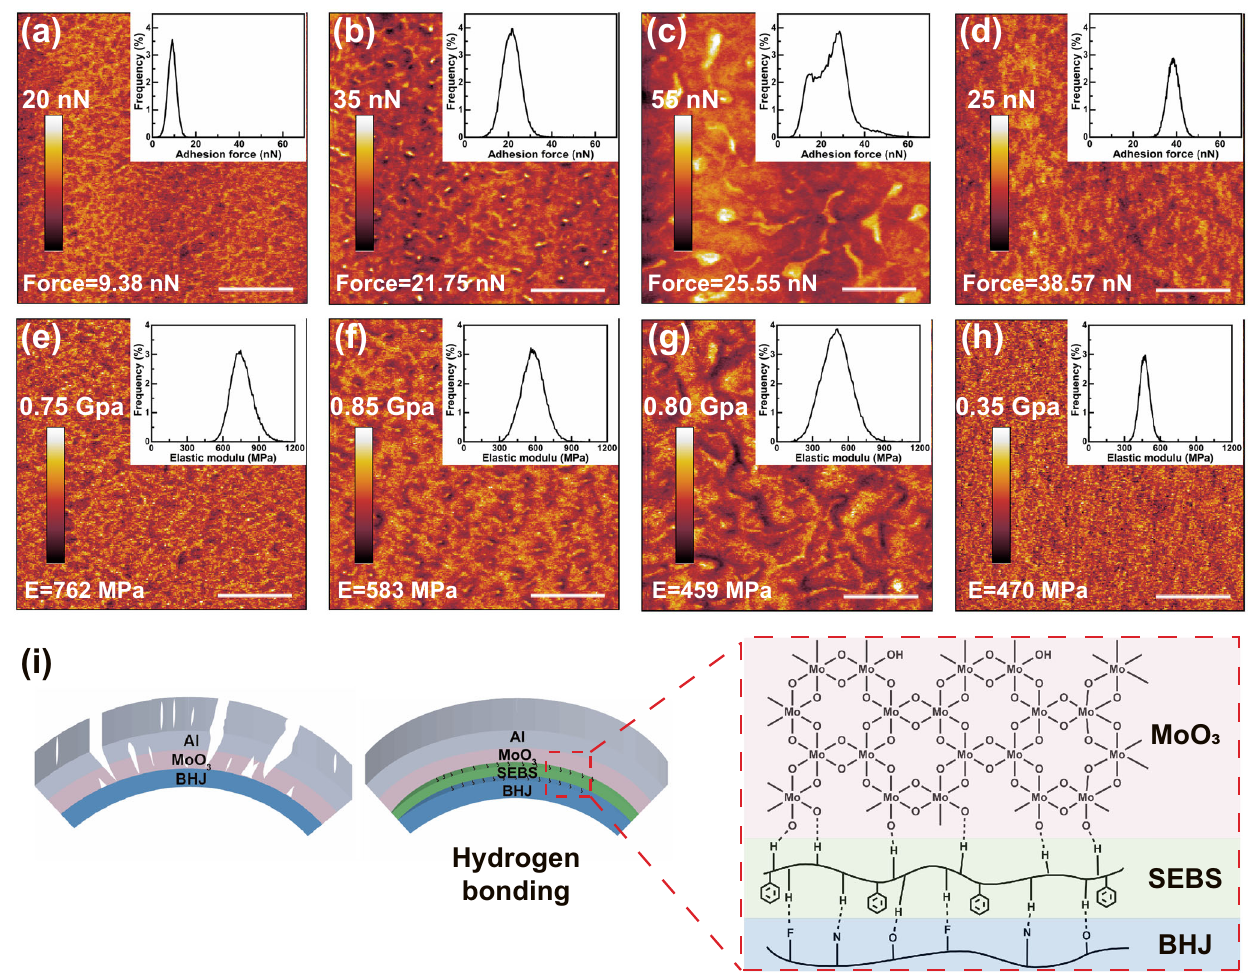
Fig. 5 Mechanism of improved bending durability of FOSCs. Adhesion images of a w/o SEBS (PM6:Y6), b 30%-SEBS doping, c 50%-SEBS doping, and d SEBS-interface fi lms were obtained by PFQNM method (thescanne d area is 2 μ m × 2 μ m). Elastic modulus images of e w/o SEBS, f 30%-SEBS doping, g 50%-SEBS doping, and h SEBS-interface fi lms obtained by PFQ NM method (the scanned area is 2 μ m × 2 μ m). i Mechanism diagram of adhesion